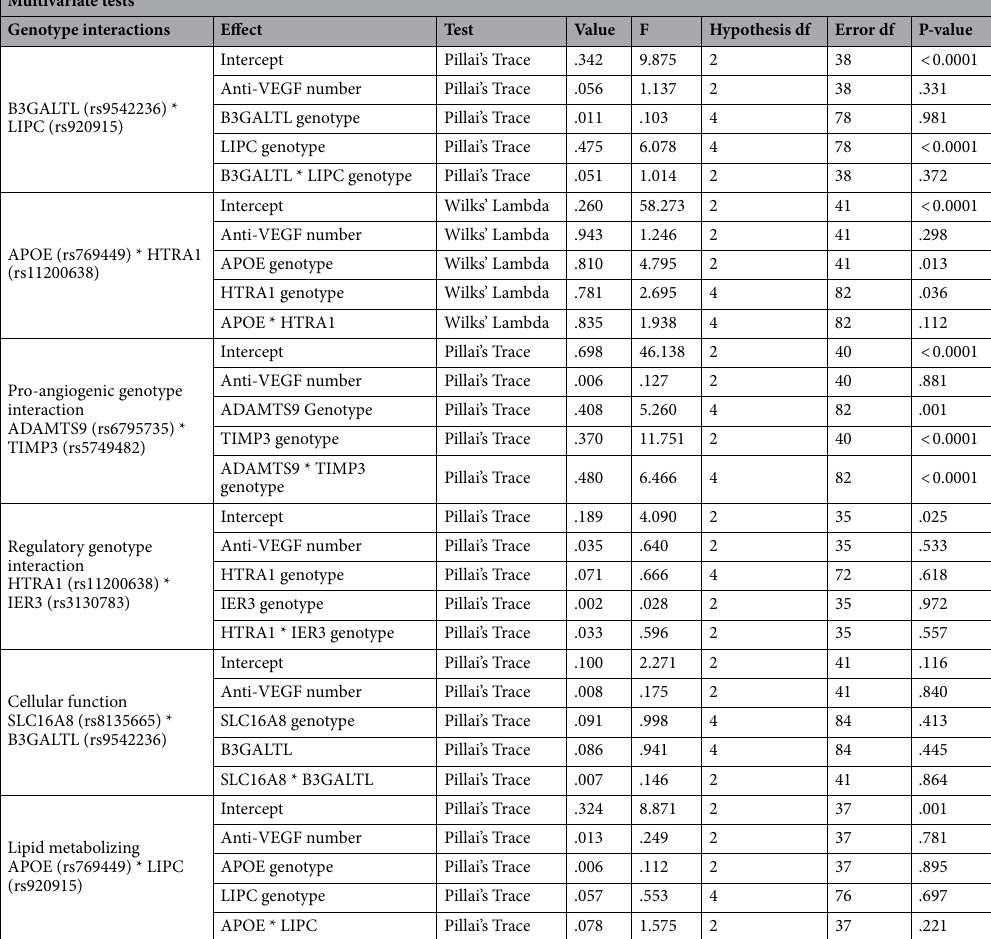
Table 7. Multivariate analysis to demonstrate genotype interaction of studied SNPs (based on their cellular functions) and influence of anti-VEGF treatment on AMD pathology. Results showed significant genotype interaction of pro-angiogenic genes including ADAMTS9 (rs6795735) and TIMP3 (rs5749482), but didn’t show direct influence of genotype interactions on number of anti-VEGF injections in Indian AMD